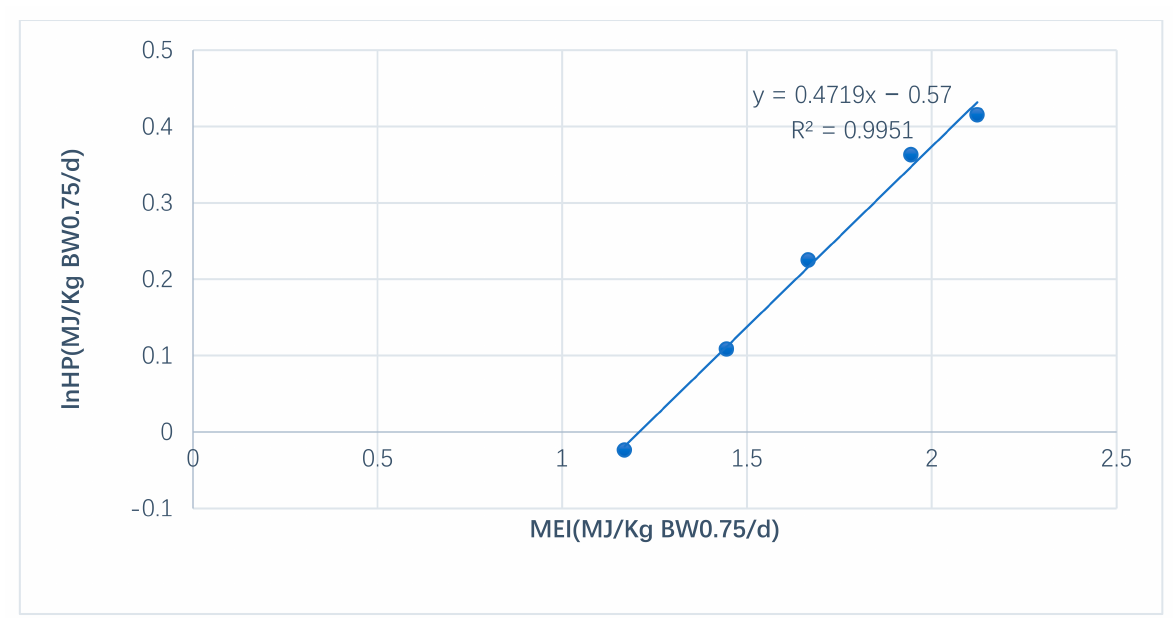
Figure 1. Determination of fasting heat production (FHP), lnHP (MJ/kg BW 0.75 d − 1 ) as a function of MEI (MJ/kg BW 0.75 d − 1 ) in duck. MEI, metabolizable energy intake; HP, heat production.